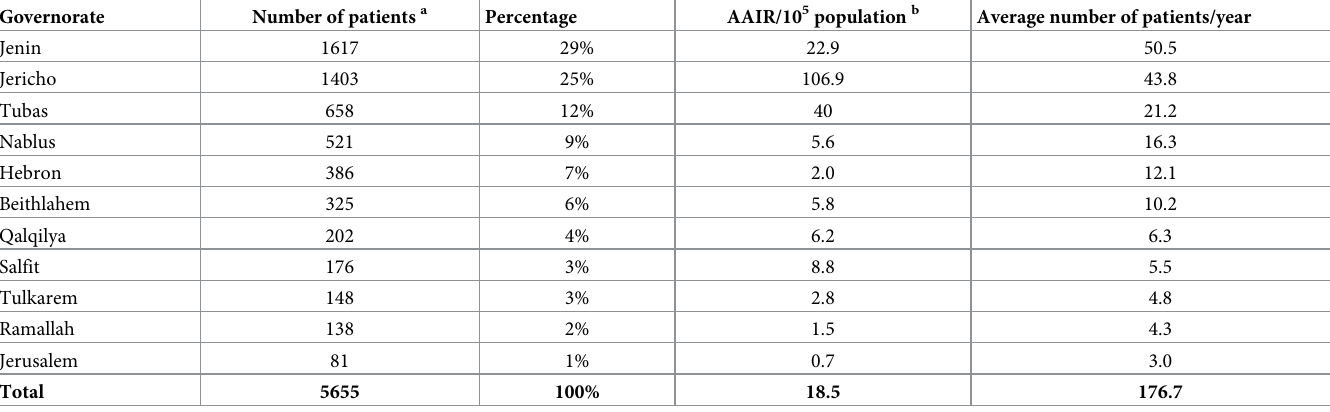
Table 1. Distribution of cutaneous leishmaniasis cases in the West Bank between 1990 and 2020.